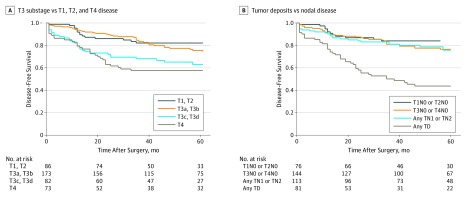
Kaplan-Meier Curves for Recurrence on Subclassification of T and N Stage on Computed TomographyT3 substage indicates T3a-T3b vs T3c-T3d category; TD, tumor deposit.